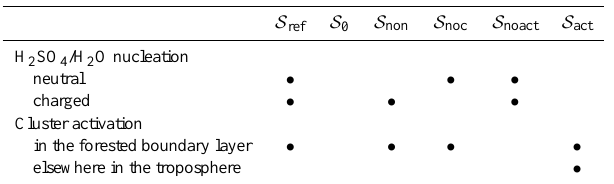
Table 2. List of simulations. Filled circles indicate that a given particle formation mechanism is used in a